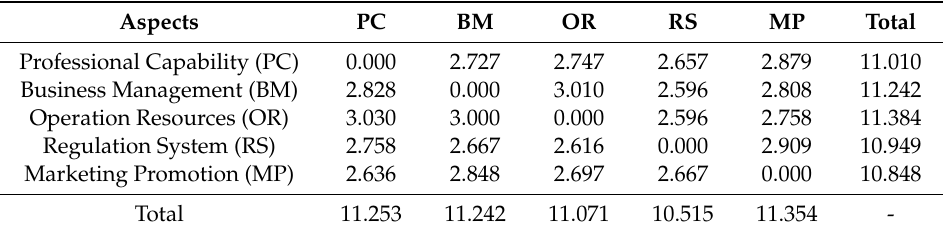
Table 4. The original average influence matrix (A).